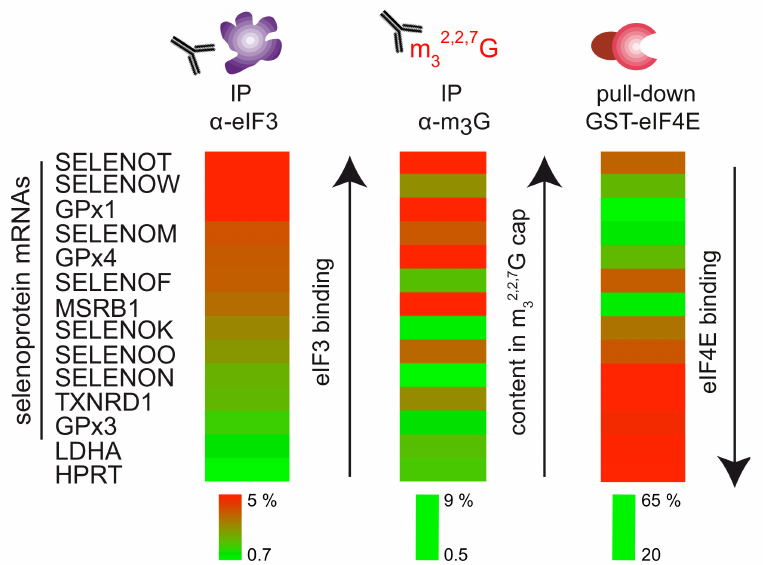
Figure 5. eIF3 binds mRNAs with hypermethylated caps that are poorly recognized by eIF4E. Heatmap representation of mRNA binding in anti-eIF3b IP is deduced from Figure 1b and compared to anti-m 32,2,7 G IP and GST-eIF4E pull-down experiments from [23]. Adapted with permission from [23]. Copyright 2014, by-nc/3.0 licence, copyright to The authors and Oxford University Press. The binding scales are represented below the corresponding heatmaps. They represent the percentage of mRNAs in the bound fractions. Maximum binding values in each set of experiments are represented in red and minimal binding values in green. Heat maps were generated with the MeV